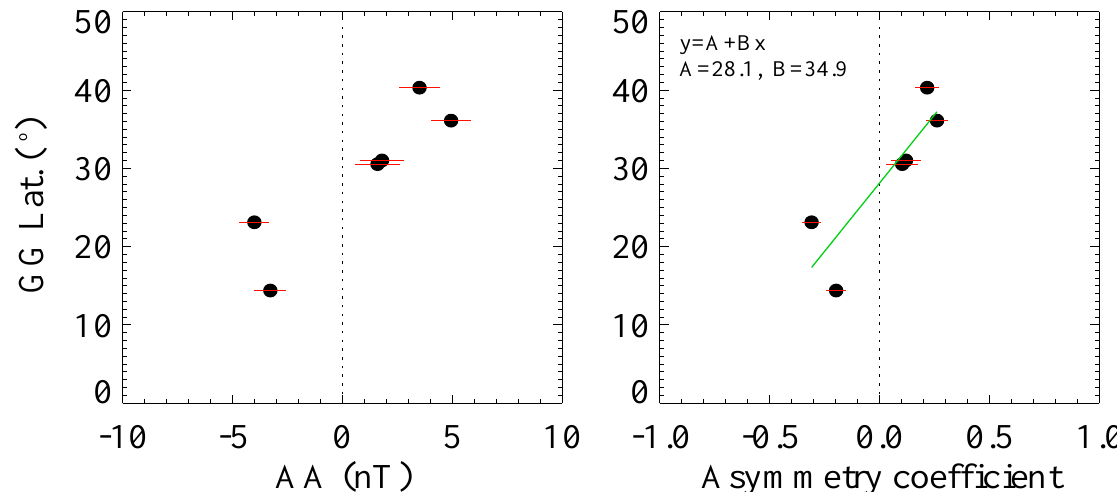
Figure 7. Dependence of the averaged equinoctial asymmetry AA and averaged asymmetry coefficient on geographic latitude. Red bars represent the SEM. Green curve in the right panel is the linear fit on the asymmetry coefficient, with fitting parameters indicated in the corner.